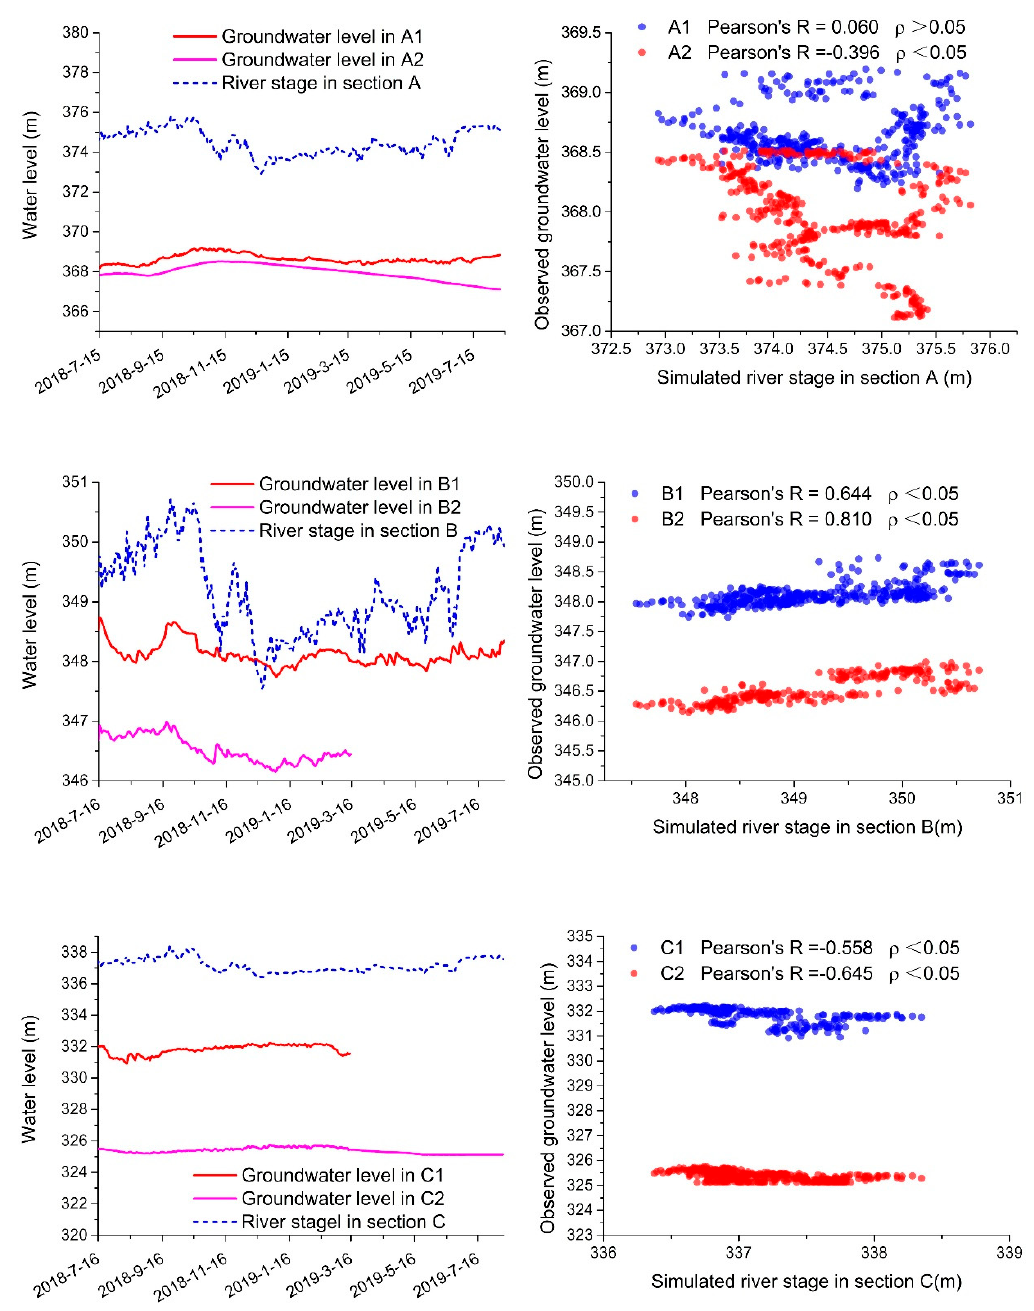
Figure 8. Observed groundwater heads, simulated river stages and their correlations at three transects. River stages on the groundwater monitoring transects were acquired from the numerical model.